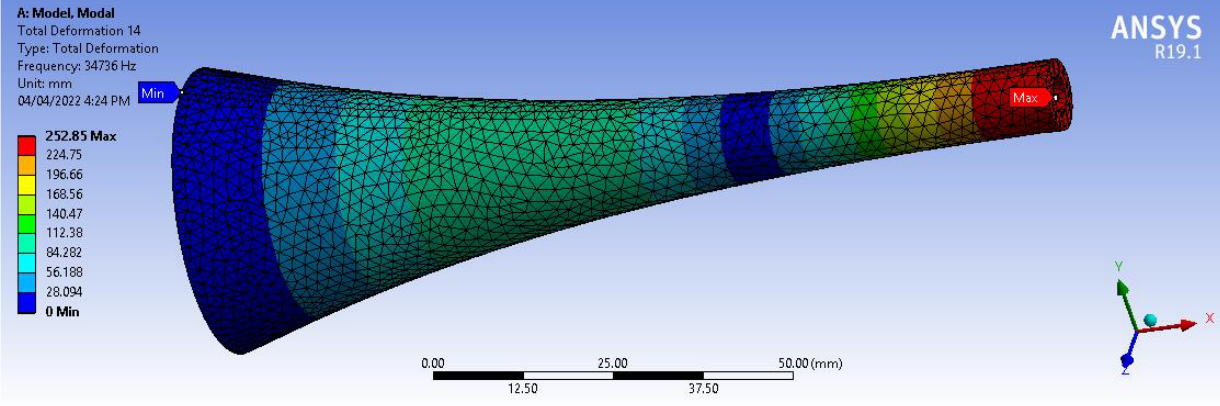
Figure 4. Resonant frequency result of titanium horn corresponding to 2 nd axial